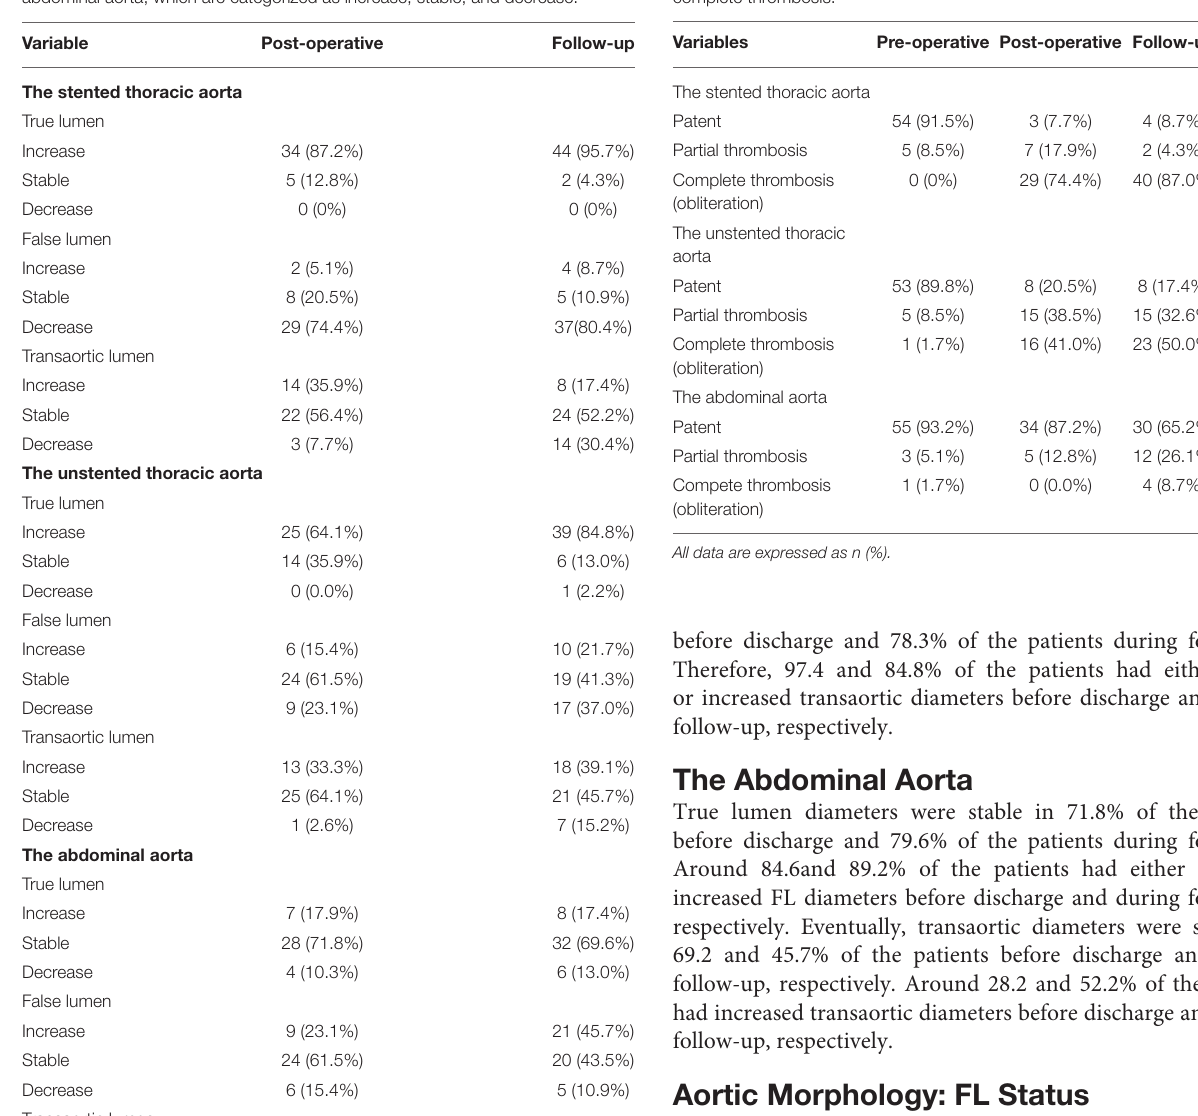
TABLE 3 | Changes in the maximum diameters of the TL, FL, and total lumen (transaortic) in the stented thoracic aorta, unstented thoracic aorta, and abdominal aorta, which are categorized as increase, stable, and